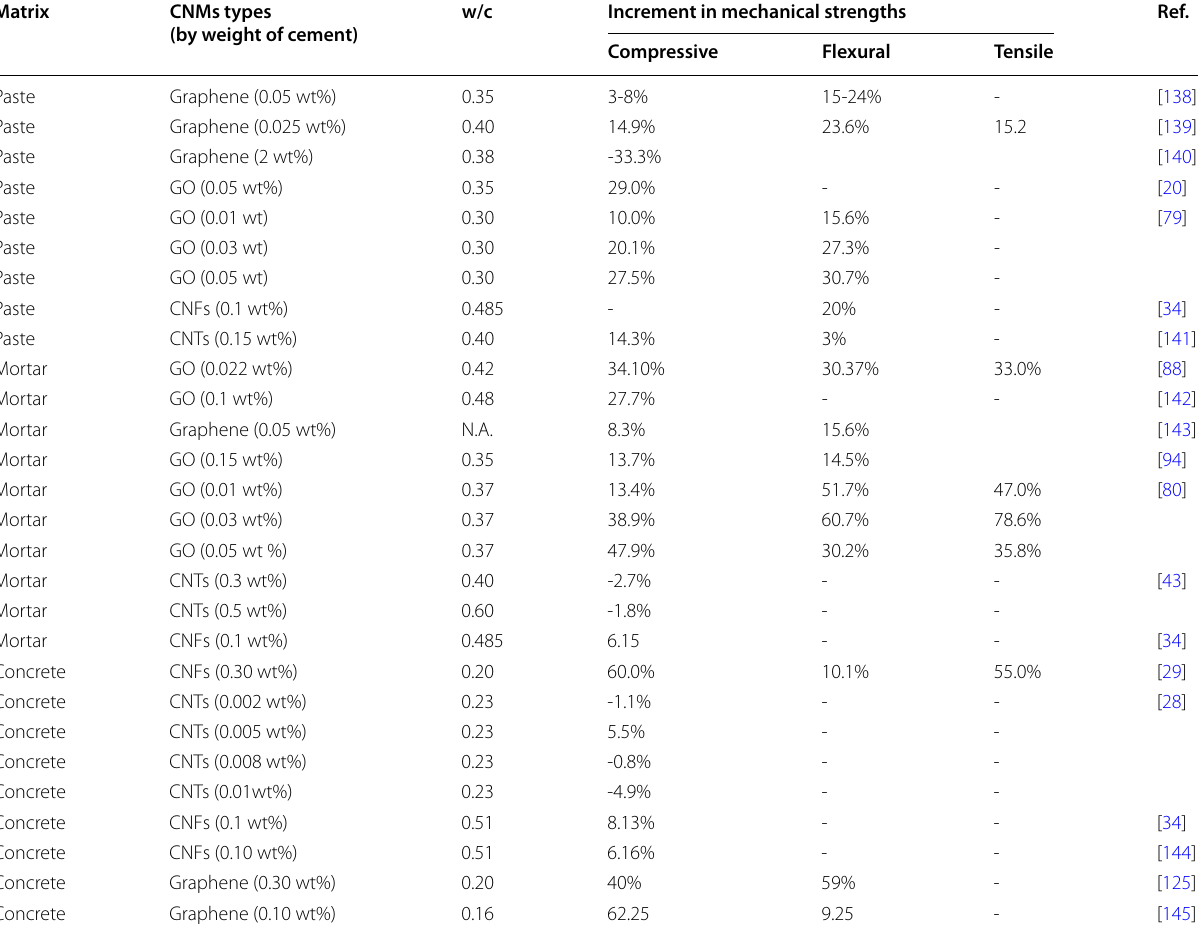
Table 4 Improvement of CNMs to mechanical properties of cement-based materials cured at 28 days